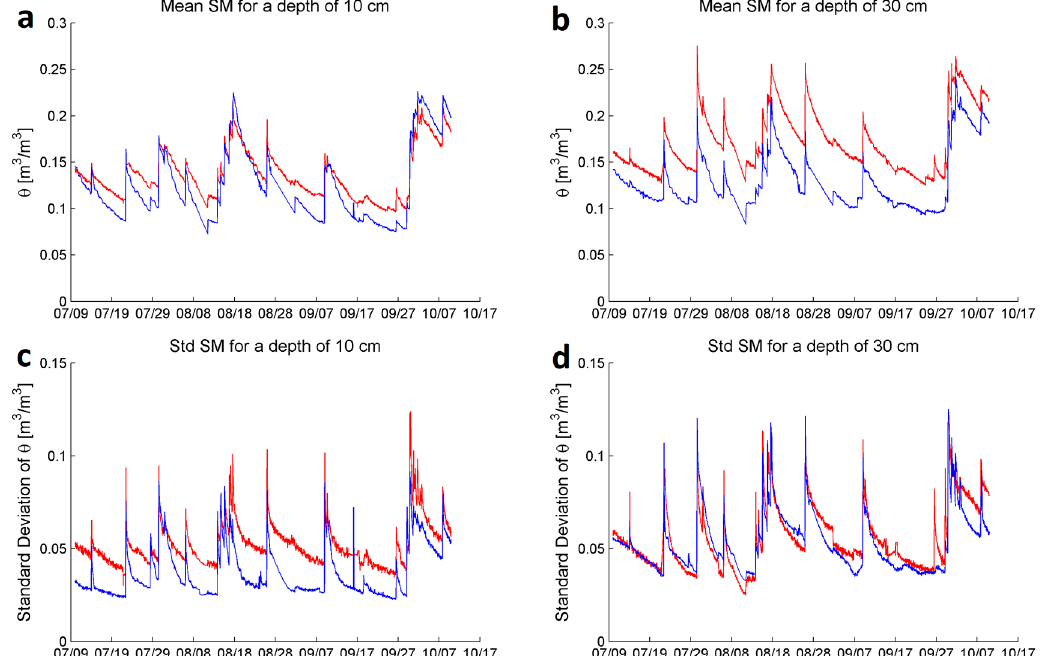
Figure 11. Comparison of the mean and standard deviation of volumetric soil moisture (SM), θ in m 3 ·m − 3 at sites 2 and 6 in red and blue, respectively, in the ASWP WSN testbed between 10 July and 10 October 2016. ( a ) Mean SM at a depth of 10 cm; ( b ) Mean SM at a depth of 30 cm; ( c ) Standard deviation of the SM at a depth of 10 cm; ( d ) Standard deviation of the SM at a depth of 30 cm.